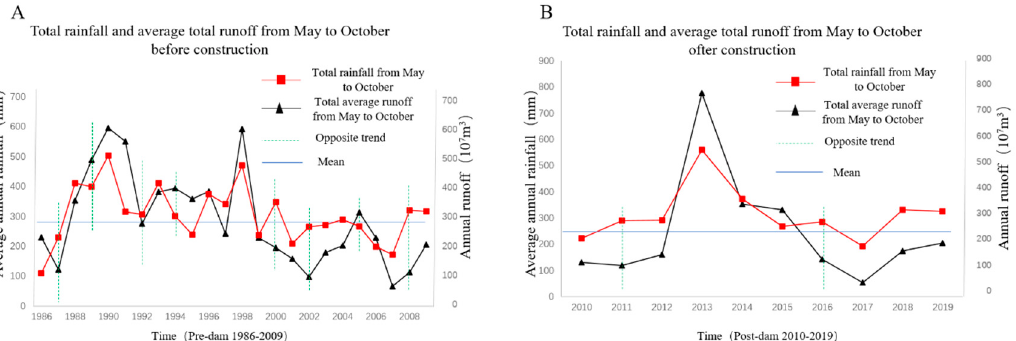
Figure 5. Trends of rainfall and runoff before and after the construction of the water conservancy project.